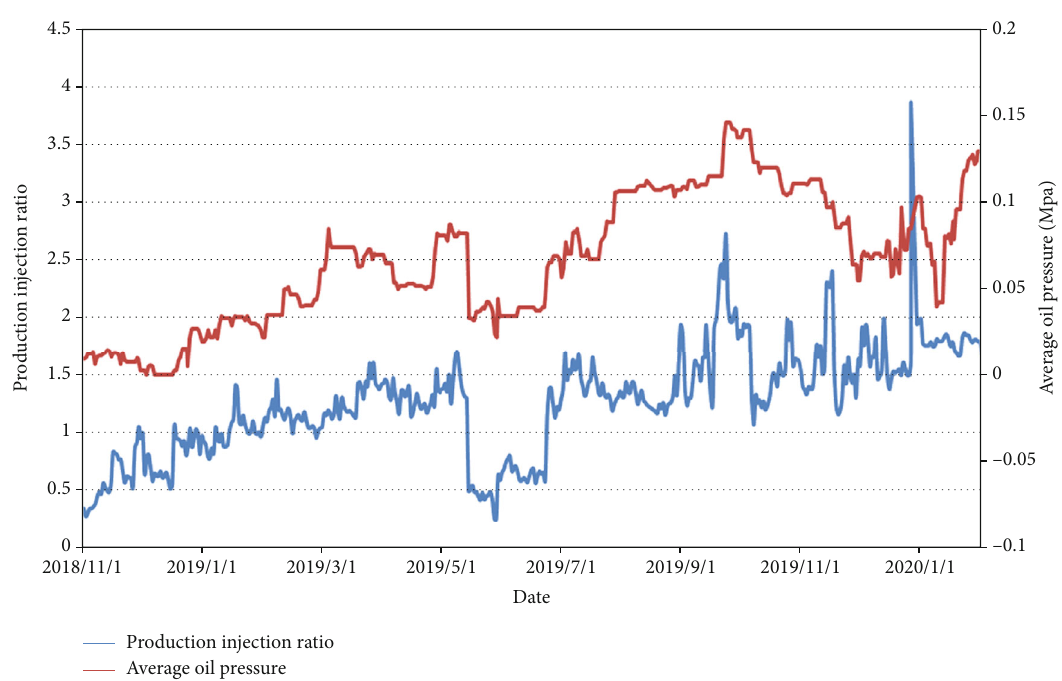
Figure 11: Average wellhead pressure and production injection ratio in the test area recorded during the fi eld